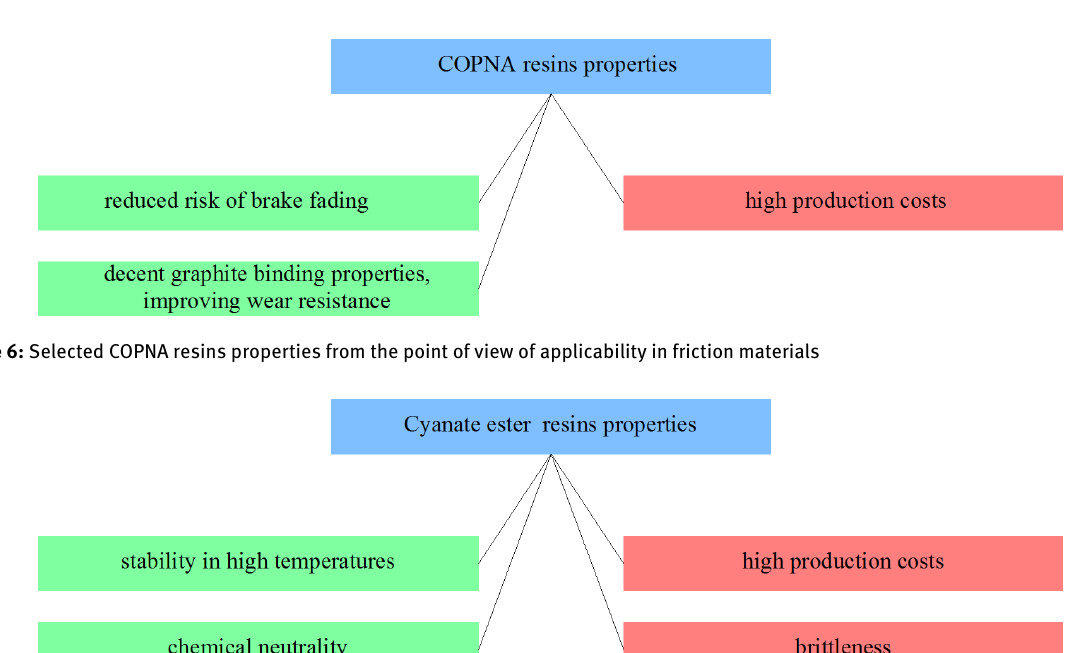
reach 700 ∘ C, greatly exceeding the degradation tempera- ture of phenol resin [60, 61].